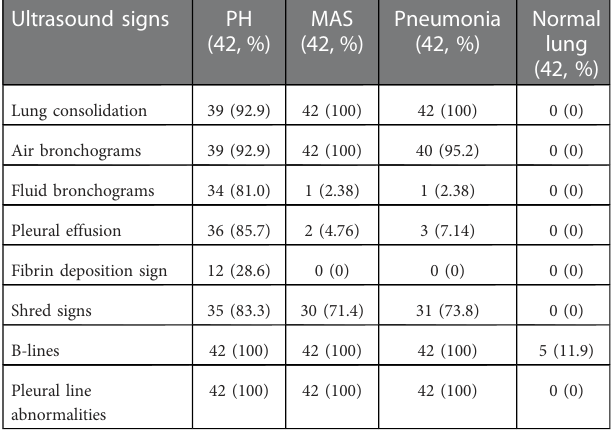
TABLE 2 The LUS performance of PH compared with the control group ( n ,